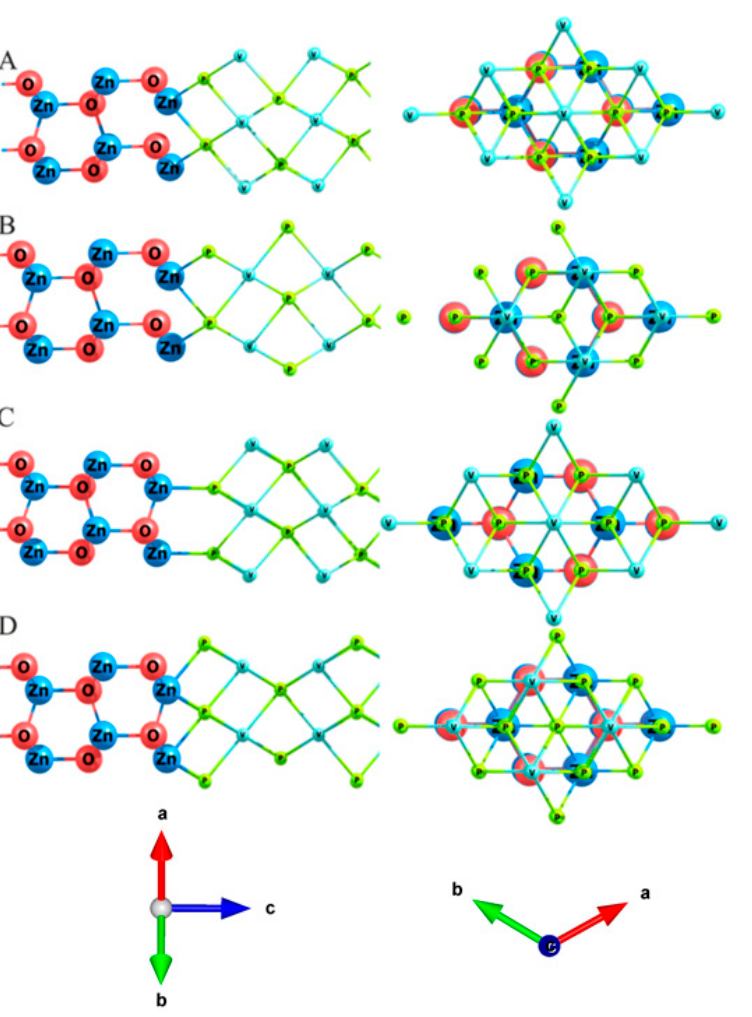
Figure 2. VP slab orientation with respect to ZnO in VP/ZnO composites. ( A ) [P_top_O:V_hex]; ( B ) [P_top_O:P_hex]; ( C ) [P_top_Zn:V_hex]; ( D ) [V_top_O:P_hex]. Table 2. Stacking energies and magnetic moments for different VP slab orientation in structures with one and four VP